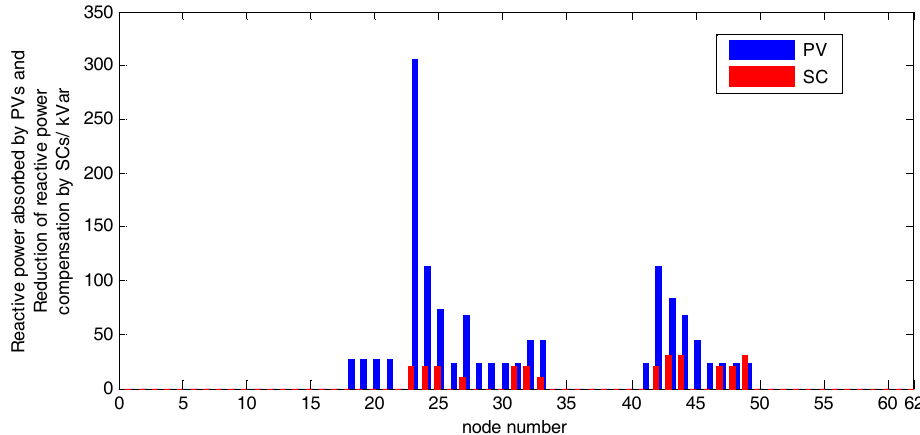
Figure 14. Reactive power absorbed by PVs and reduction of the reactive power compensation by SCs under the proposed method.